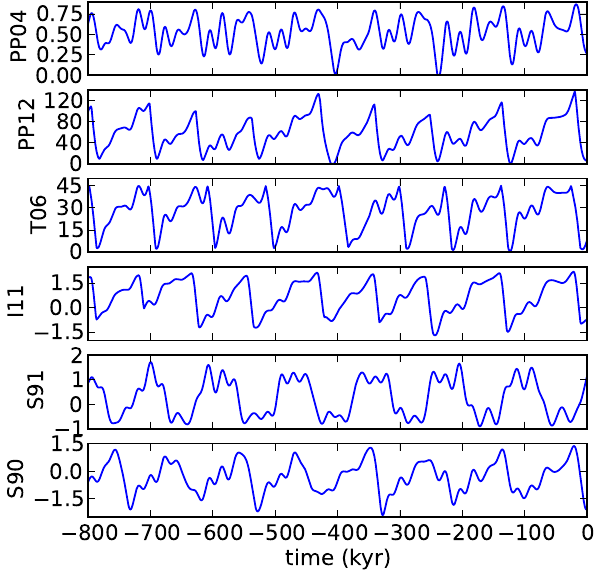
Fig. 15. Pullback attractors obtained for 6 models over the last 800ka, forced by astronomical forcing with the parameters of the original publications. Shown is the model component representing ice volume. Units are arbitrary in all models, except in T06 (ice volume in 10 15 m 3 ) and PP12 (sea-level equivalent, in